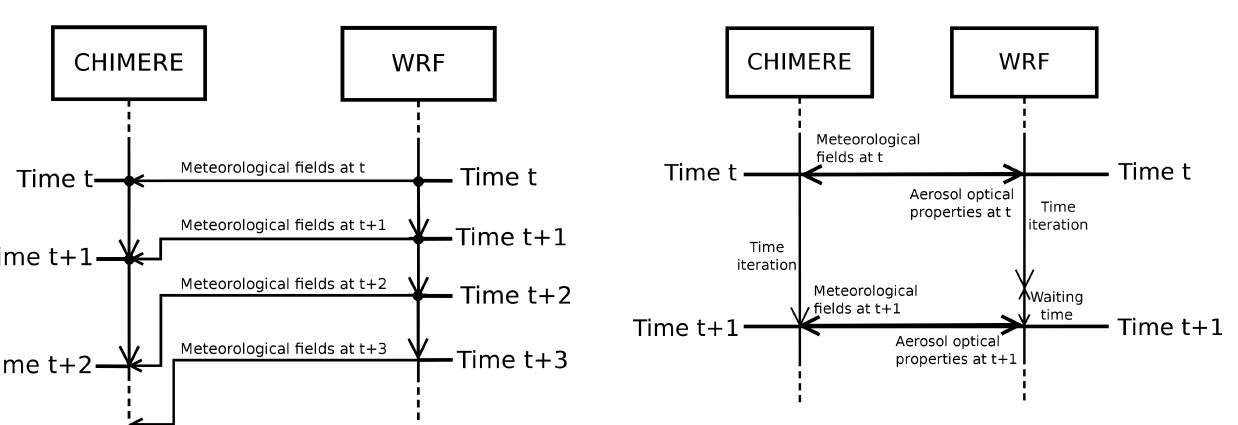
Figure 3. Operations scheduling in a WRF-CHIMERE simulation with the aerosol optical properties feedback.